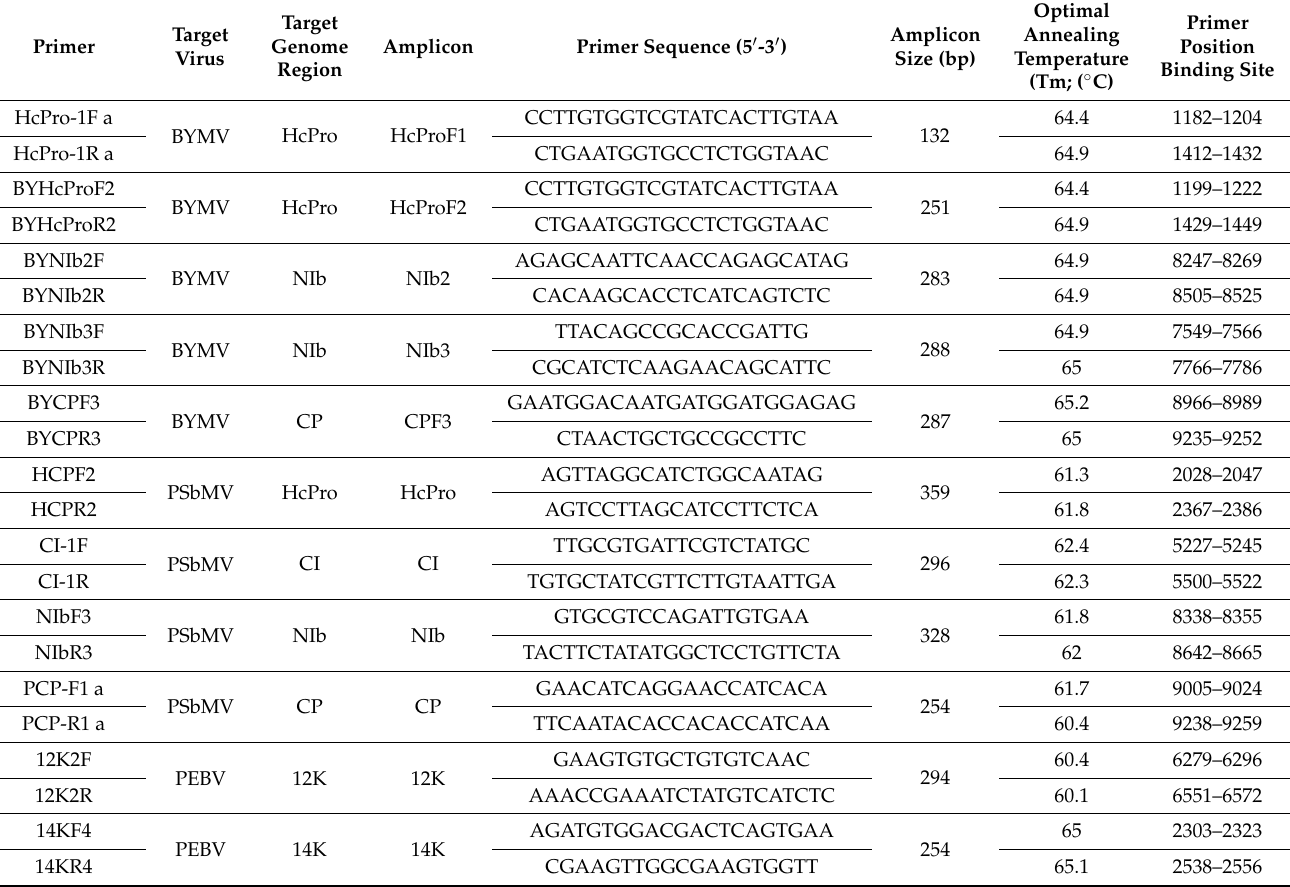
Table 2. Nucleotide sequence, genome location, amplicon size and optimal annealing temperature of 16 primer pairs used in both singleplex and multiplex PCR